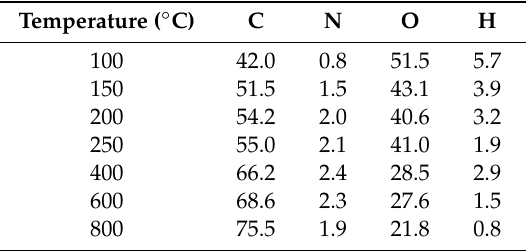
Table 4. Elemental analysis of organic elements C, N, O, and H of CP after different stabilization and carbonization temperature in at.%.